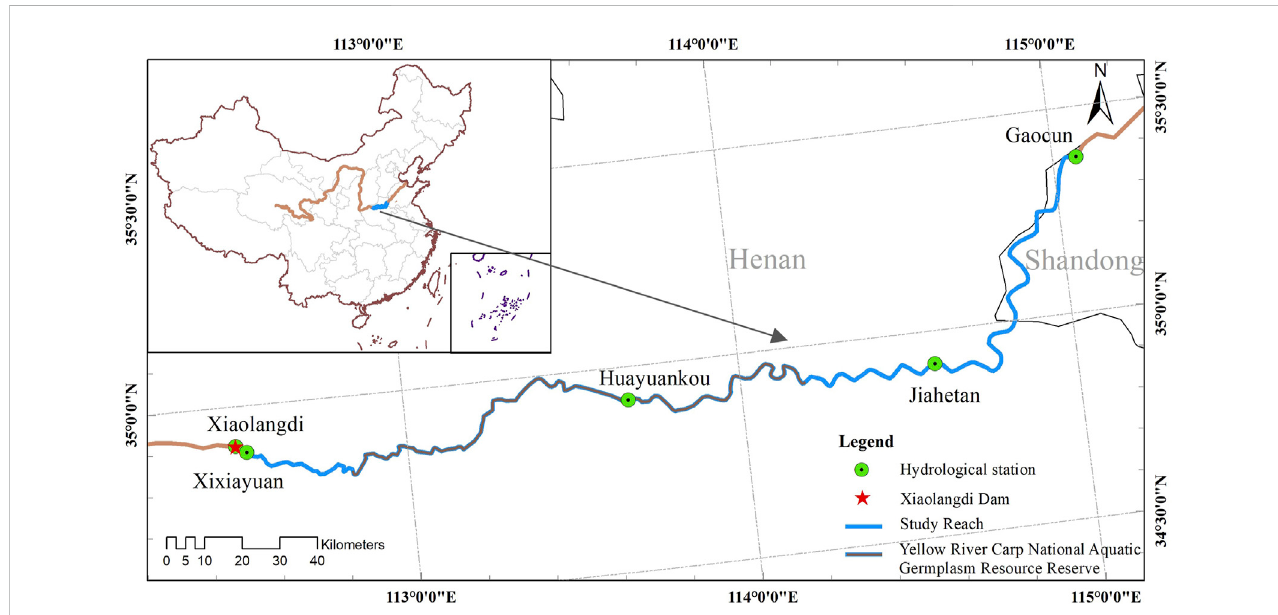
FIGURE 1 Geographical location of the Yellow River in China and the study area comprised the Yellow River downstream of the Xiaolangdi Dam, between Xiaolangdi and